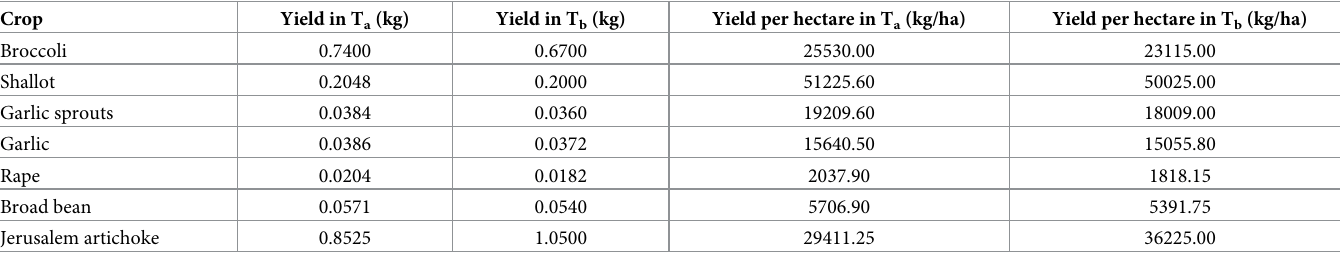
Table 5. Yield per single plant and yield per hectare of two cultivation methods. Crop